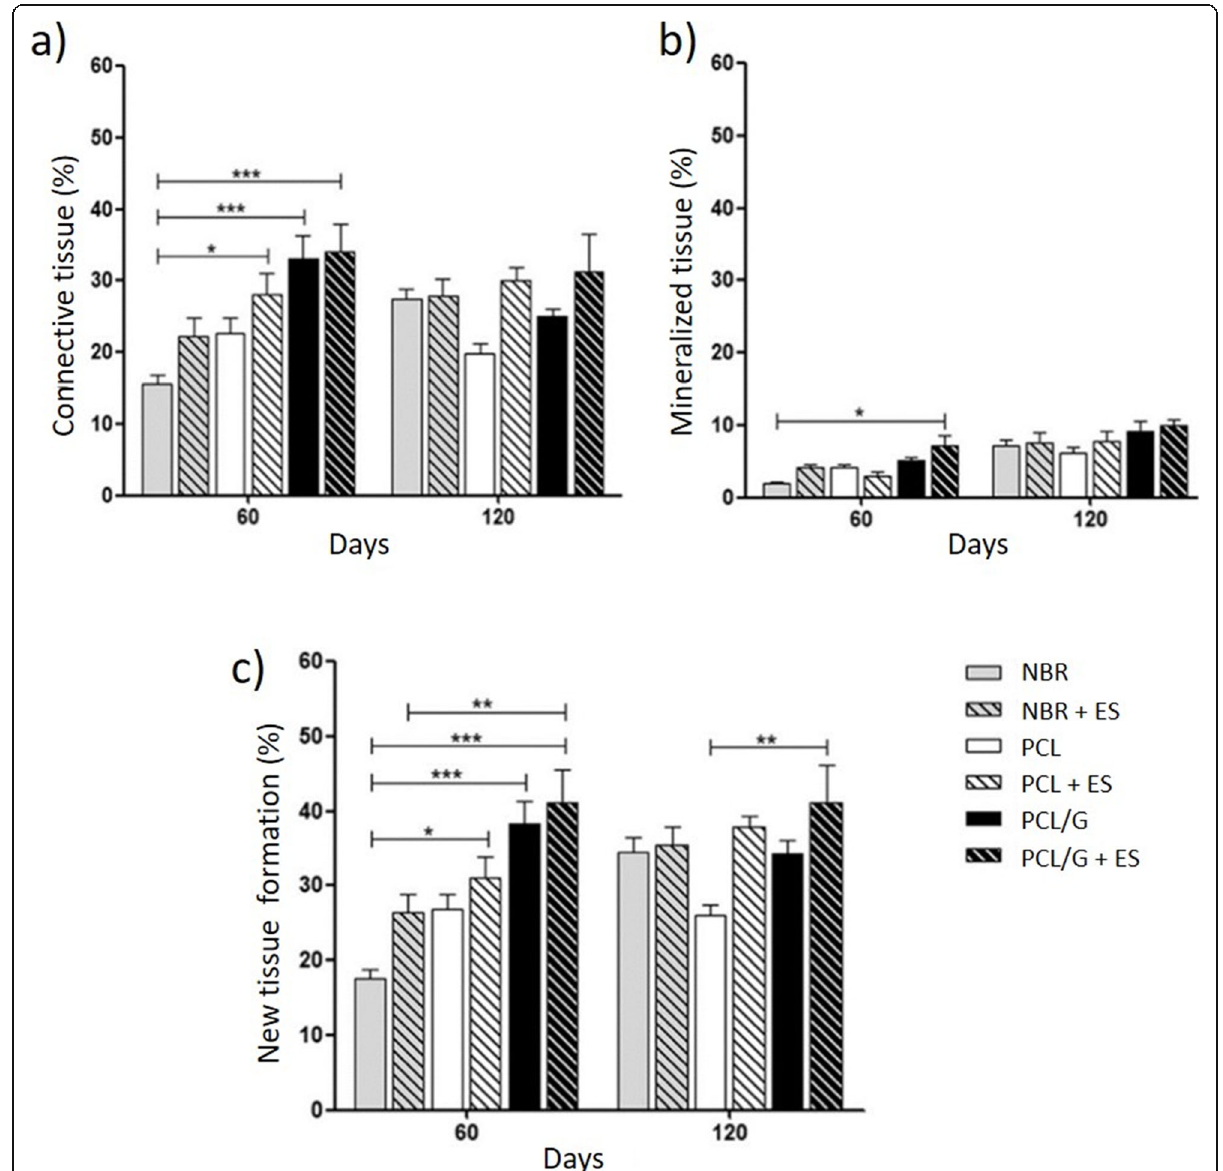
Fig. 9 Evolution in time of the formation of ( a ) Connective tissue; ( b ) mineralized bone tissue; and ( c ) cumulative tissue formation (connective+ bone tissues) on the PCL and PCL/0.78 wt% of graphene (G) scaffolds, with and without electrical stimulation (ES). NBR stands for “ natural bone regeneration “ or control group. Reproduced with permission from